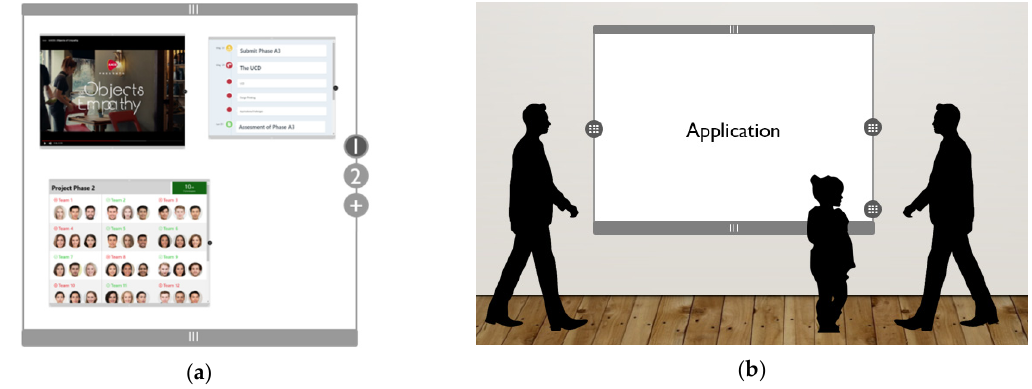
Figure 8. ( a ) An example of a workspace. ( b ) Reachable interactive components.